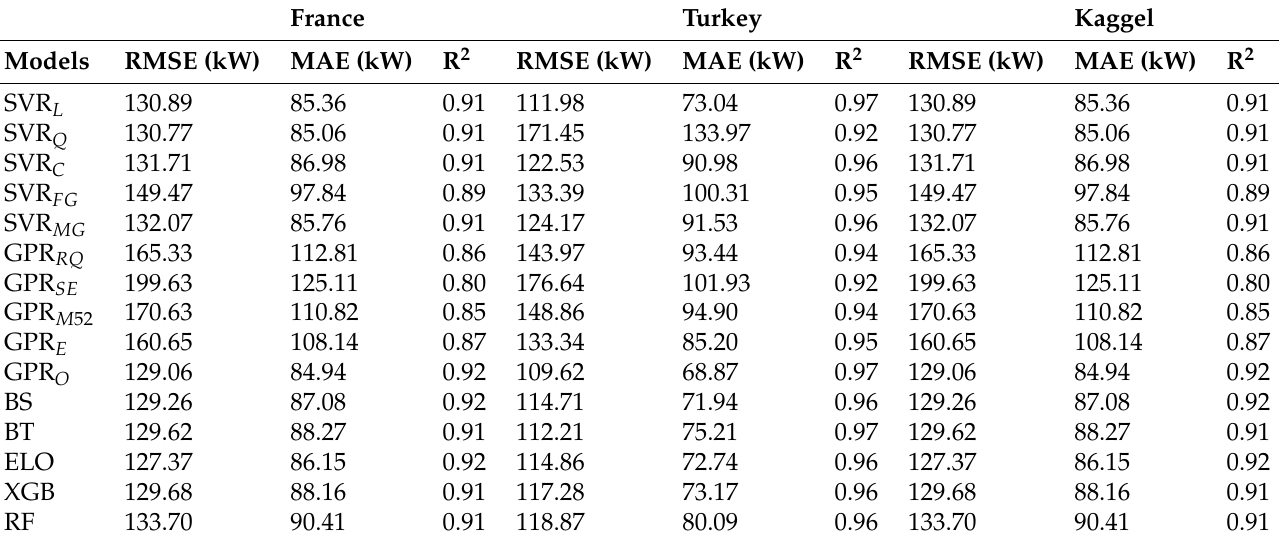
Table 4. Forecasting results using dynamic models.